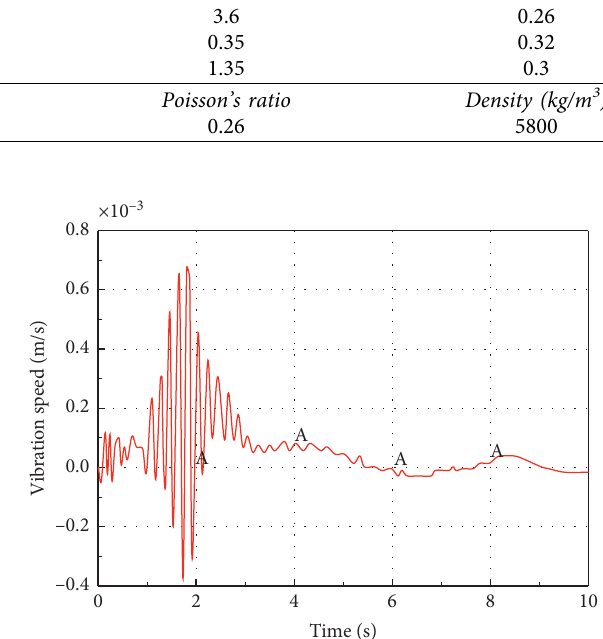
Figure 4: Velocity-time history curve of monitoring point in